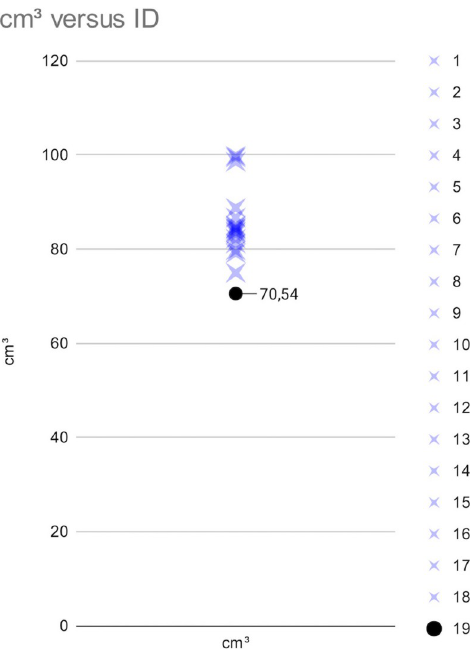
Fig 9. Graph showing the distribution of endocranial volumes (expressed in cm 3 ) in the skull with HFI vs in the skulls used for comparisons.